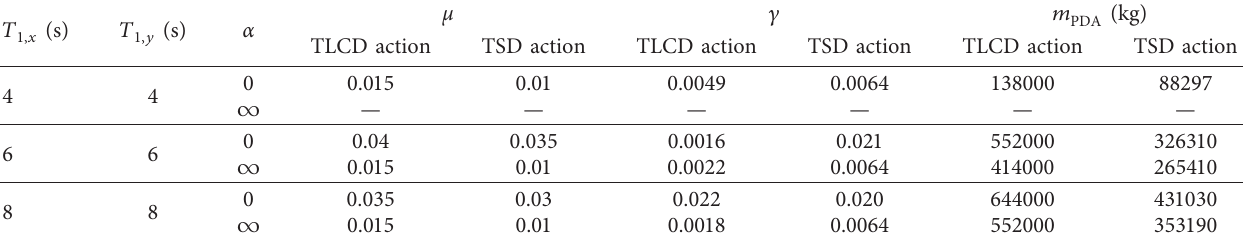
� T � H /46, m � 200000kg/m, and R 1 ,x 1 ,y